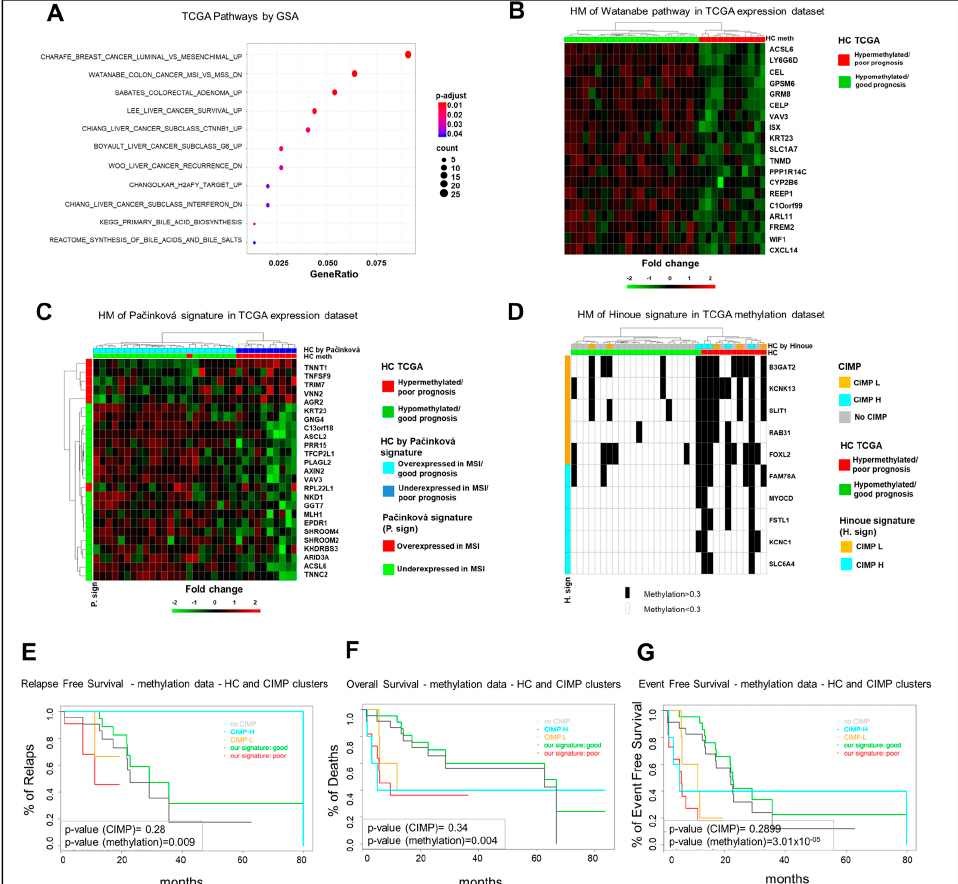
Figure 4. The characterization of the poor prognosis hypermethylated cluster highlights a microsatellite instability (MSI)-like/CpG-island methylator-high (CIMP-H) phenotype. ( A ). Significant enrichments for signaling pathways upon Gene Set Analysis (GSA). ( B ). Heatmap (HM) of differentially expressed genes enriching the Watanabe gene set in 33 mCRCs from the TCGA COAD dataset. ( C ). Heatmap of differentially expressed genes from the MSI-like gene expression Pa č ínková signature in 33 mCRCs from the TCGA COAD database. ( D ). Heatmap of CIMP status in 33 mCRCs from the TCGA database according to the eight-gene signature. CIMP status is labeled in black. ( E – G ). Relapse-Free, Overall, and Event-Free survival curves of TCGA COAD patients according to the eight-gene signature or CIMP status. HC, hierarchical clustering; DR, drug response.